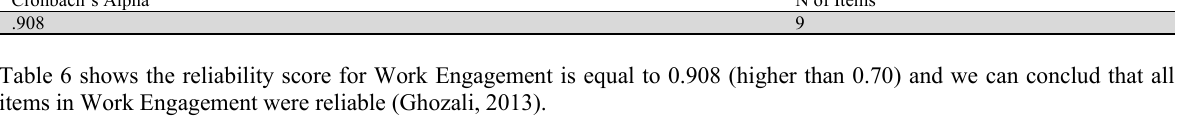
Work Engagement Reliability Statistics Result Cronbach’s